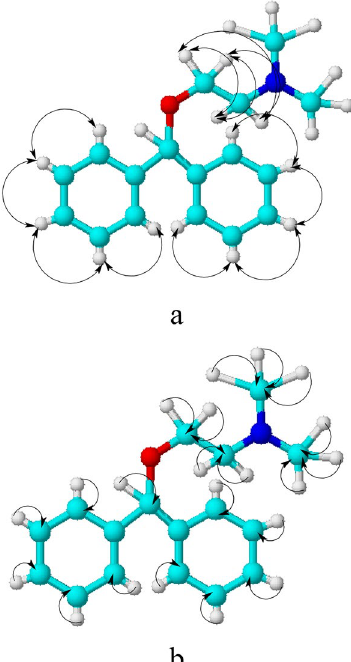
Fig. 3 Correlations in the COZY ( a ) and HMQC ( b ) spectra of 1. Drawn in ACD/ChemSketch